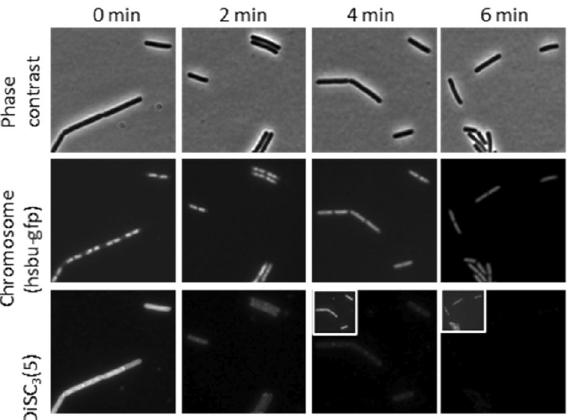
Figure 9. Single-cell measurement of chromosome decondensation and membrane potential in a time course experiment in the presence of tatiomicin (32 μg/mL). Phase contrast (top panels), fluorescence microscopy of B. subtilis HsbUGFP (chromosome marker) (middle panel) and stained with the voltage sensitive dye DiSC3(5) bottom panel. Cellular DiSC3(5) fluorescence values where quantified over time. The bar chart depicts the fluorescent intensity values of individual cells (> 30) (see